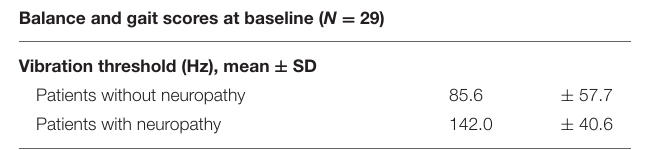
TABLE 1 | Patients’ baseline